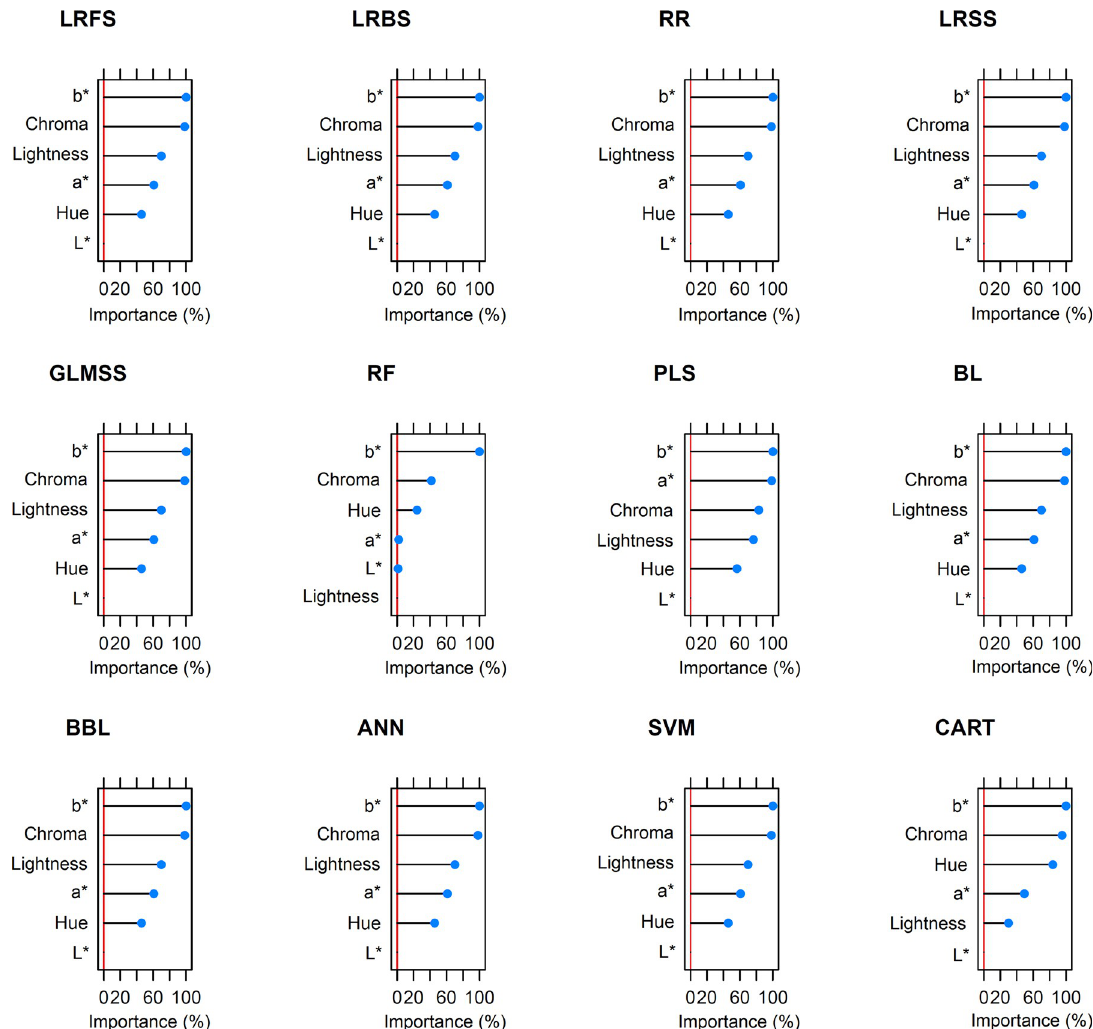
Fig 5. Relative importance of colorimetric indices for predicting total carotenoid content using 12 prediction models: Linear Regression with Forward Selection (LRFS), Linear Regression with Backwards Selection (LRBS), Ridge Regression (RR), Linear Regression with Stepwise Selection (LRSS), Generalized Linear Model with Stepwise Feature Selection (GLMSS), Random Forest (RF), Partial Least Squares (PLS), the Bayesian Lasso (BL), the Bayesian Blasso (BBL), Artificial Neural Network (ANN), Support vector machine (SVM), and Classification and regression trees